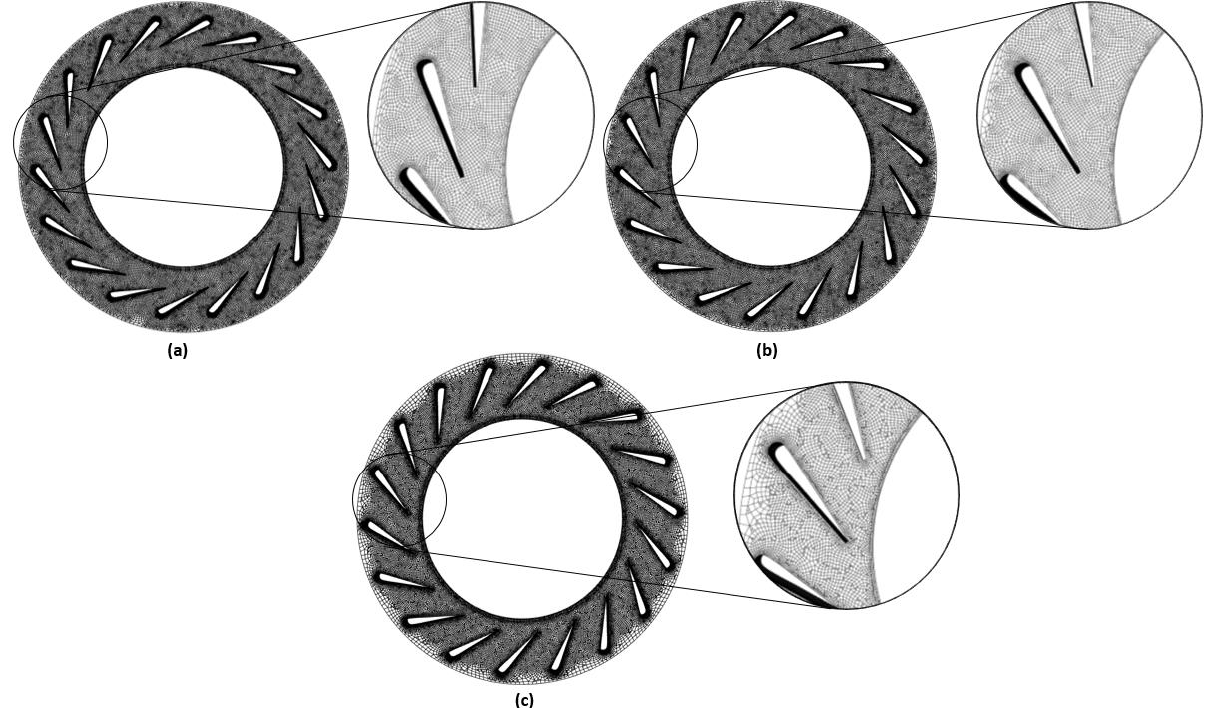
Figure 10. The numerical mesh of the VTG vanes domain at the angle ( a ) 20°, ( b ) 30°, ( c ) 40°.